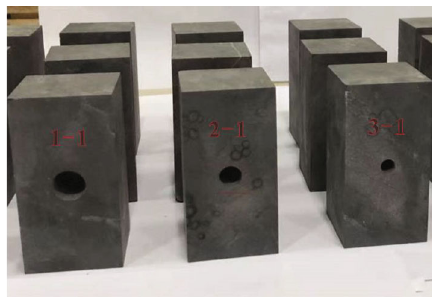
Figure 3: The processed siltstone